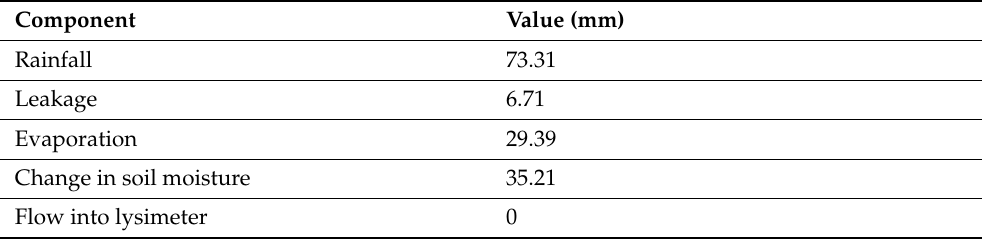
Figure 9. Soil moisture during October 2018 for lysimeter 1 ( a ) and lysimeter 2 ( b ). Table 3. Monthly water balance for October